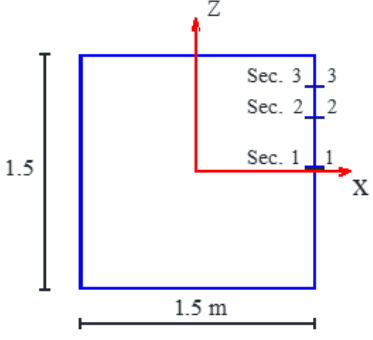
Figure 7. Sections of the silo.